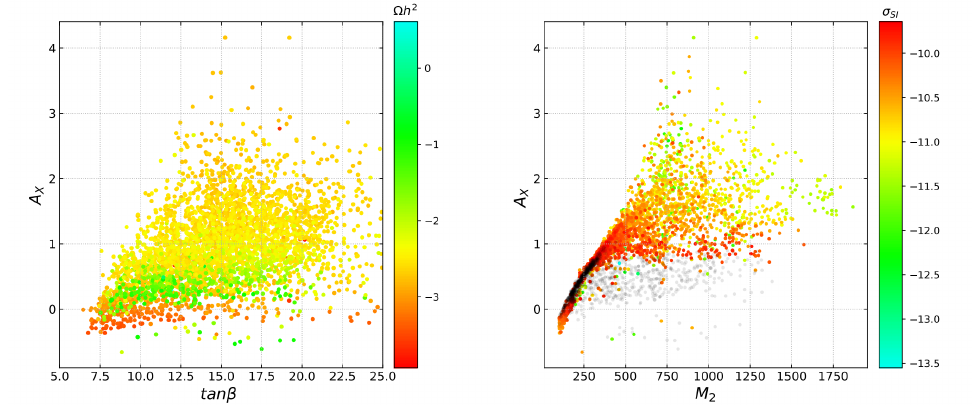
Figure 6 . All samples in figure 3 are projected on tan β - A X plot and M 2 - A X plot. The colorbar represents the common logarithm of DM relic density in the left plot. Black samples in the right plot are excluded by DM direct detection limits, and the others are surviving samples. For surviving samples, the colorbar in the right plot represents the common logarithm of σ close to green color are much safer, samples close to red color are near DM direct detection limits.